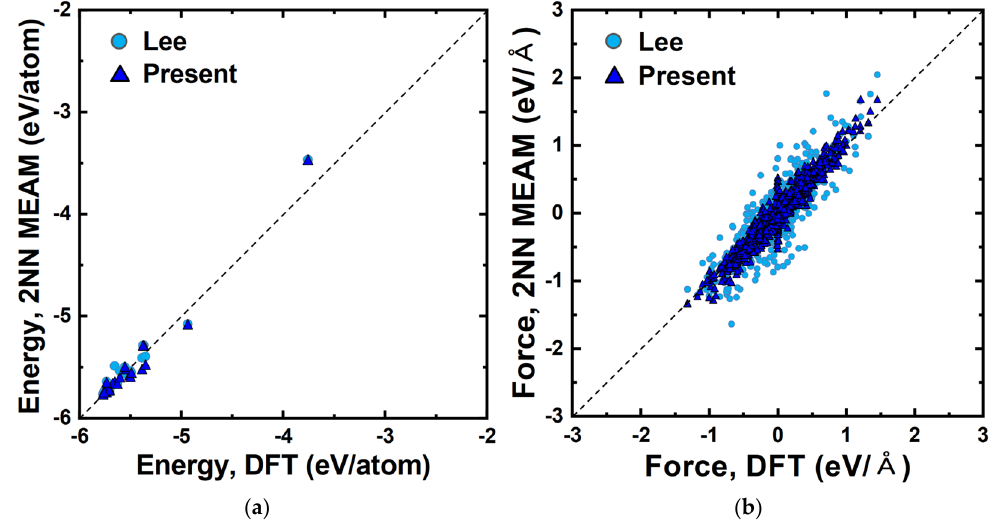
Figure 1. Scatter plots of ( a ) energies and ( b ) forces, demonstrating the fitting accuracies with respect to the present DFT calculation. The values obtained using the present and previous (Ref. [69]) 2NN MEAM interatomic potentials for pure Pt are compared. The dashed lines represent ideal correlations between the 2NN MEAM potentials and the DFT calculation.